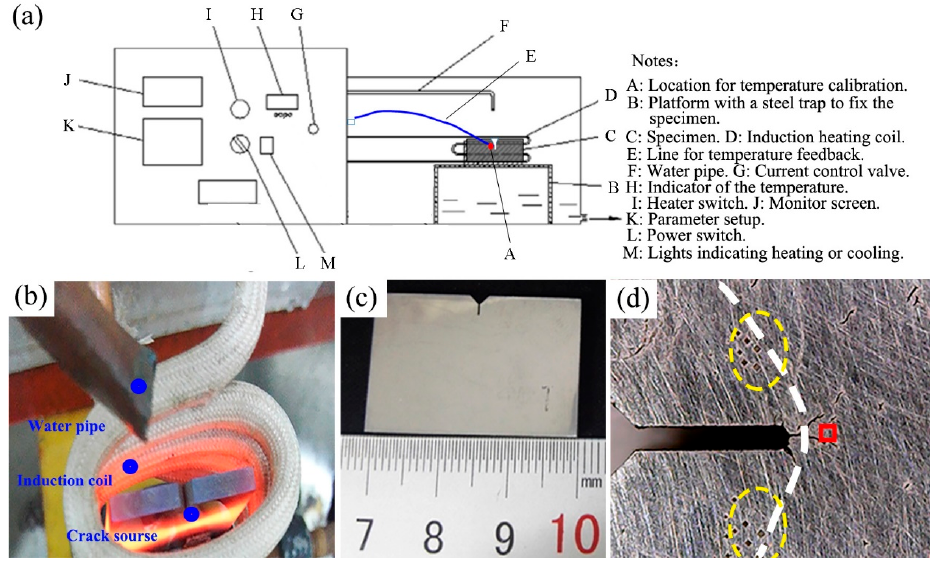
Figure 2. ( a ) Sketch of TF testing machine. ( b ) Specimen photo during TF tests. ( c ) Specimen for the TF test. ( d ) Photograph that indicates where the hardness indentations were